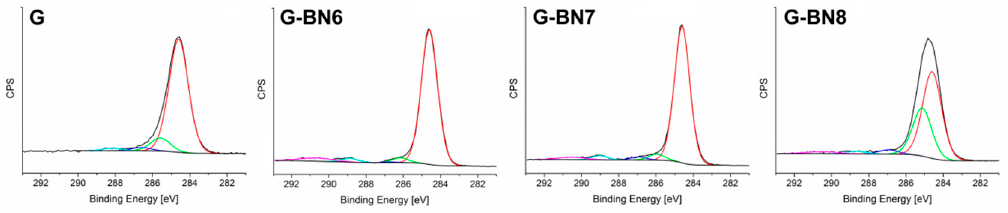
Figure 9. Deconvoluted XPS spectra of the C1s region of pristine graphene and synthesized graphene derivatives (G-BN6, G-BN7, G-BN8).